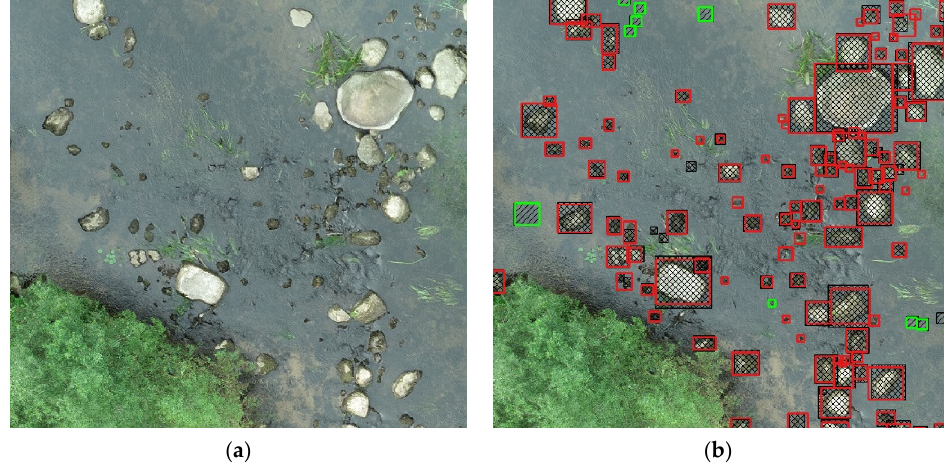
Figure 8. The original image ( a ) and the results of boulder detection ( b ). Red and green borders represent manually labelled bounding boxes BAW (red) and BUW (green). The patterns of cross and diagonal lines indicated inference results of BAW and BUW classes, respectively.